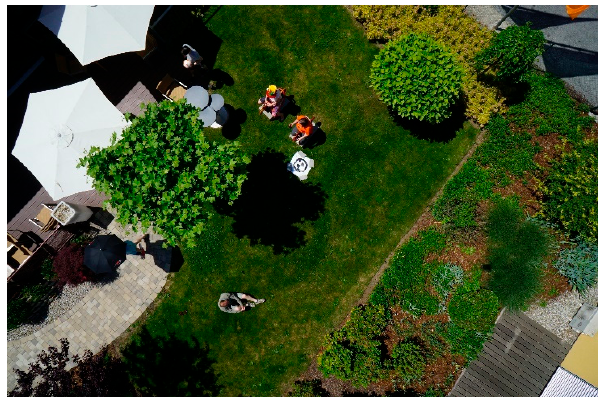
Figure 3. Sample image of Aerial Semantic Segmentation Dataset by Kaggle. Mendeley Thermal and Visible Aerial